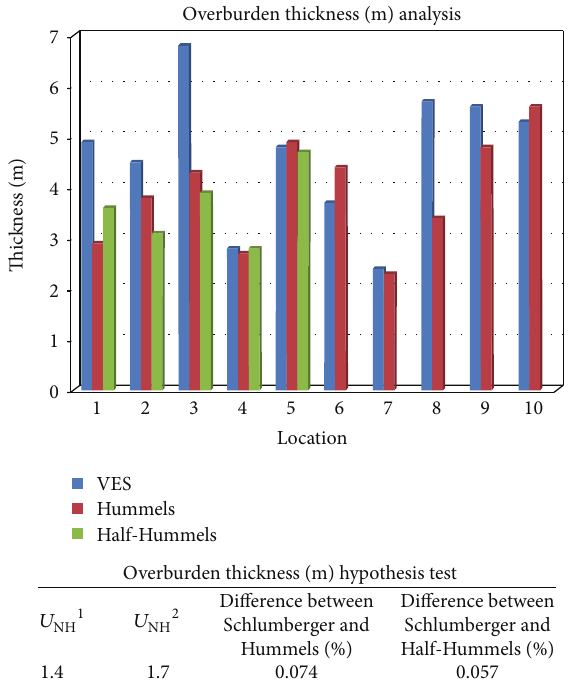
Figure 13: Bar chart and statistical test of hypothesis table for the different array methods comparing overburden thickness for locations on banded